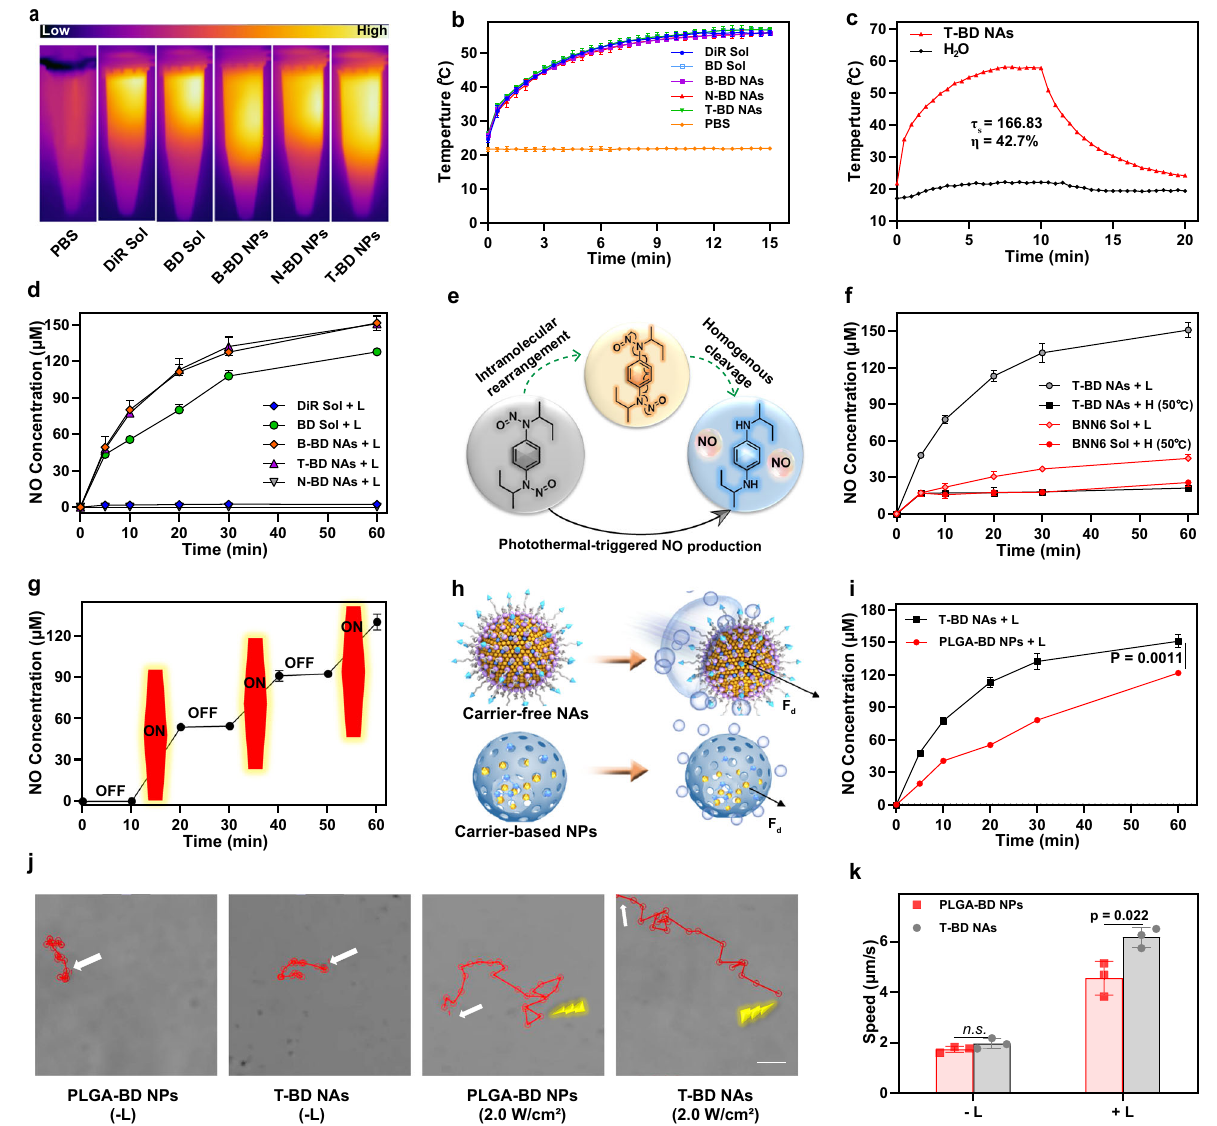
Fig. 3 | Laser-triggered NO generation and self-fueled autonomous motion. In vitrophotothermalheating a imageand b curvesunderlaserirradiation(2W/cm 2 ). Data arepresented asmean±SD ( n =3independent experiments). Source data are providedasaSourceData fi le. c Invitrophotothermalconversionef fi ciencyofT-BD NAs. d NO release curves under laser irradiation (2W/cm 2 ). Data are presented as mean±SD( n =3,independent experiments). Source data are provided as aSource Data fi le. e Chemical mechanisms of NO generation from BNN6: intramolecular rearrangement and homogenous cleavage of N-NO bonds. f NO release curves of BNN6 Sol and T-BD NAs under heating (50°C) or laser irradiation (2W/cm 2 ). Data are presented as mean±SD ( n =3, independent experiments). Source data are provided as a Source Data fi le. g Off-on NO generation variations by the switch of laser irradiation (2W/cm 2 ). Data are presented as mean±SD ( n =3, independent experiments). Source data are provided as a Source Data fi le. h Schematic repre- sentation of NO generation and autonomous motion features of carrier-free NAs